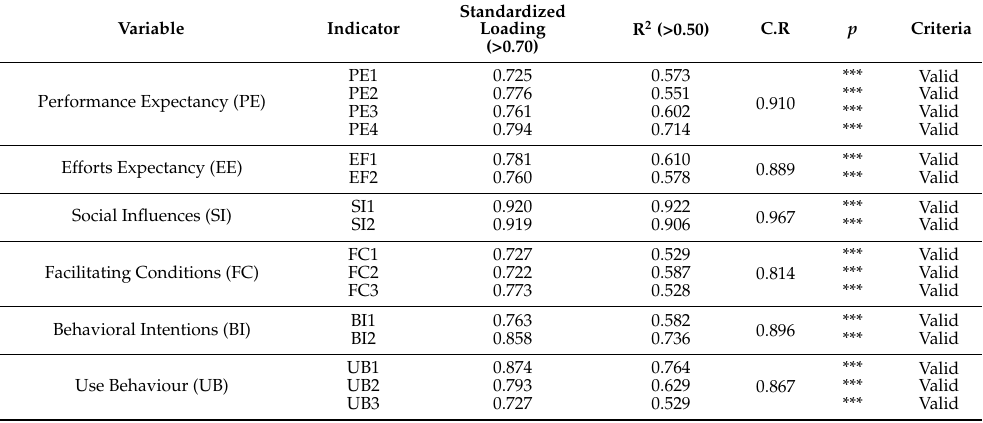
Table 4. Full model validity instrument test results. Note: *** p <